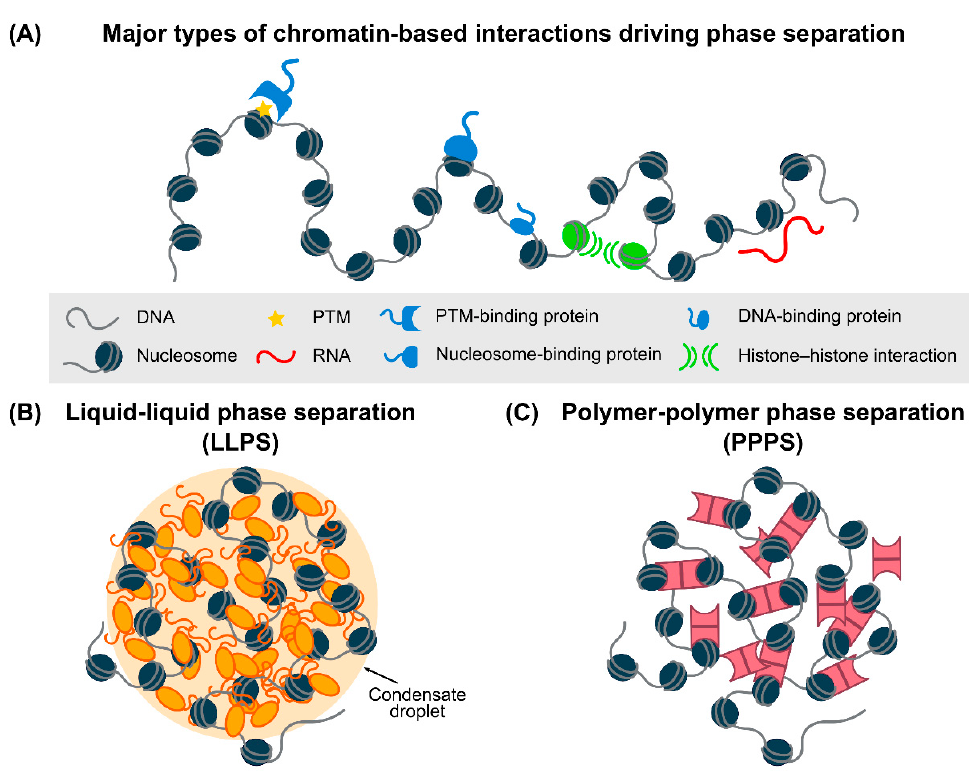
Figure 1. Schematic representation of chromatin-based phase separation. ( A ) Major types of chromatin–protein and chromatin–RNA interactions that can drive chromatin-based phase separation, including direct binding of proteins or RNAs to DNA/nucleosomes or to post-translational modifications (PTMs), as well as inter-nucleosome or -histone tail interactions. ( B ) Liquid–liquid phase separation as promoted by weak and multivalent interactions between chromatin and chromatin-associated factors (orange). ( C ) Polymer–polymer phase separation takes place through the oligomerization of multiple bridging proteins (pink) that draw different regions of the chromatin scaffold together via nonspecific interactions.